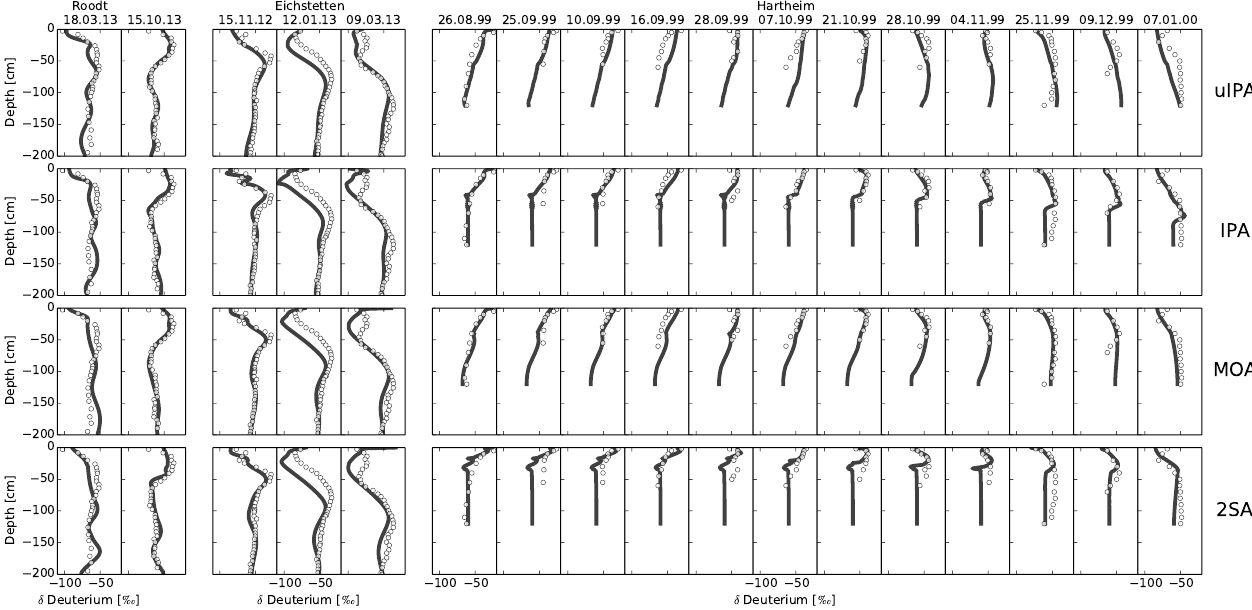
Figure 2. Observed (circles) and simulated (lines) pore water deuterium concentrations at each study site and at various dates. Simulations done with the best parameter set derived from the three different inverse model approaches. Axes scaling kept constant for each subplot.